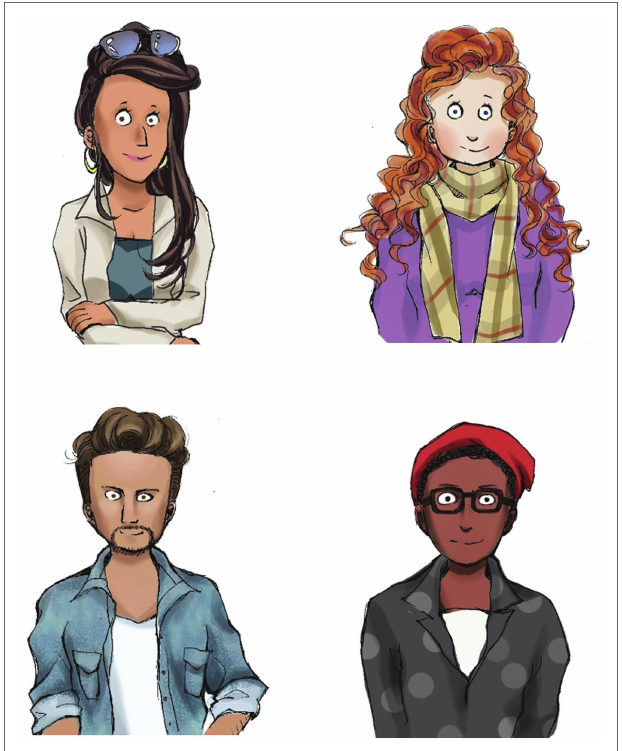
FIGURE 1 | There are four characters used in this experiment, these are the images that correspond to each character. Top left – Ana, Top right – Liz, Bottom left – Matt, and Bottom right – Will. These pictures are copyrighted to Chan et al. (2018), and used by